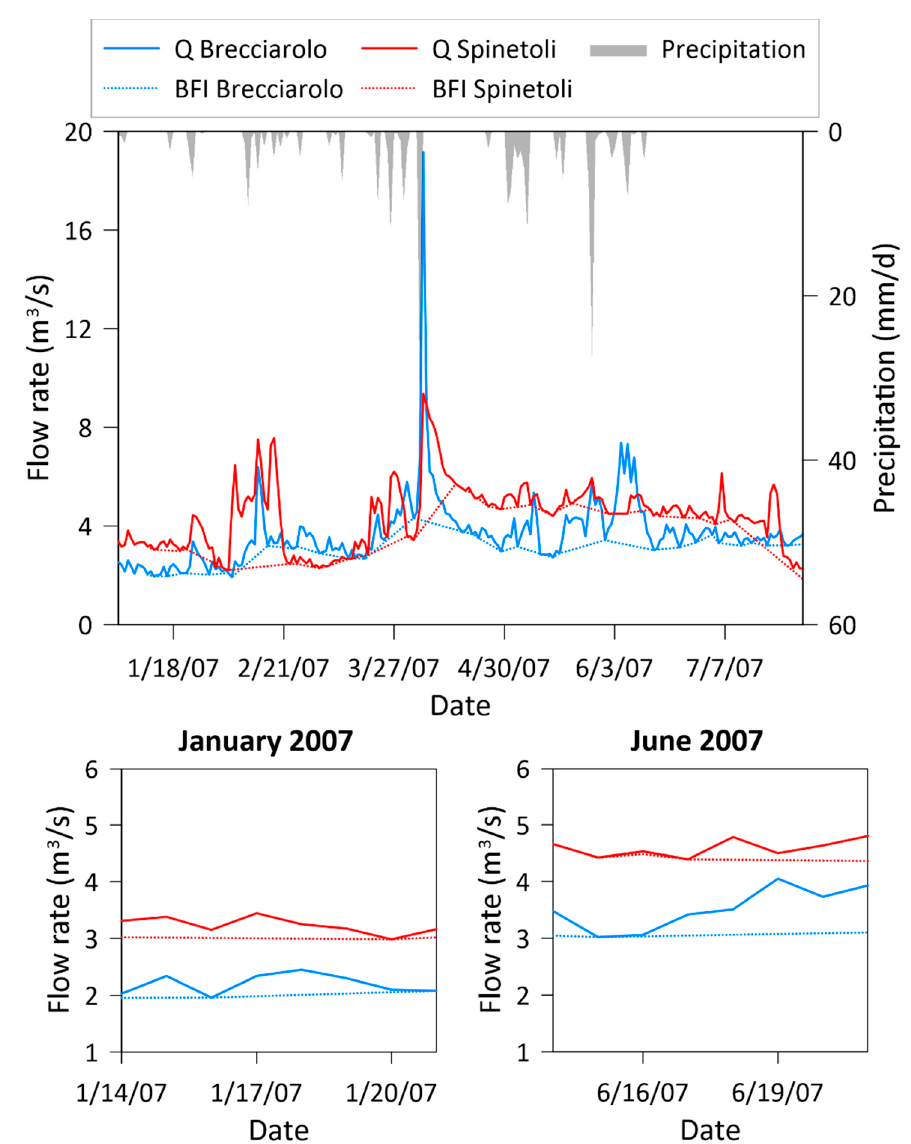
Figure 6. Mean discharge flow rate and precipitation in Brecciarolo and Spinetoli stations and their calculated baseflow index from January to July 2007 ( upper panel ). Lower panels show magnifications of the 14–21 January 2007 period ( lower left panel ) and the 14–21 June 2007 period ( lower right panel ).